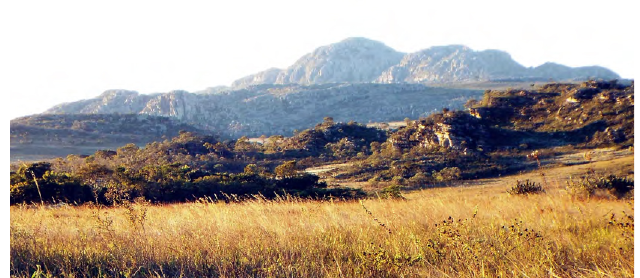
Figure 2. Campo limpo area and upland mesophytic semideciduous forest habitat in Sempre Vivas National Park, northern Minas Gerais, Brazil, where two Euryzygomatomys spinosus specimens (MDIA078 and MDIA086) were collected. Photo by Pacheco